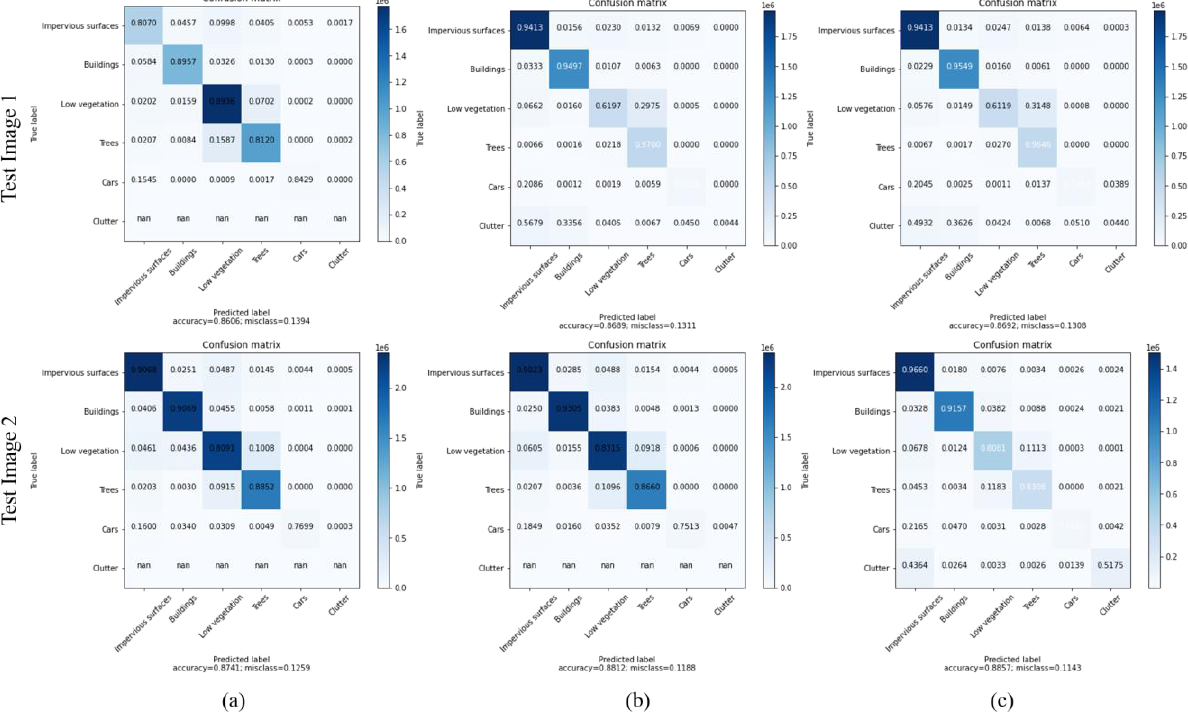
Figure 8. Confusion matrix of the proposed semantic segmentation network. (a) Model Seg , (b) Model Seg+GAN , (c) Model Seg+GAN surface class is shown in white, building features in blue, trees in green, vegetation features in cyan, cars in yellow, and background objects in red. The results of the implementation of methods Model Seg+GAN and Model Seg+WGAN have shown the superiority of the proposed model in semantic